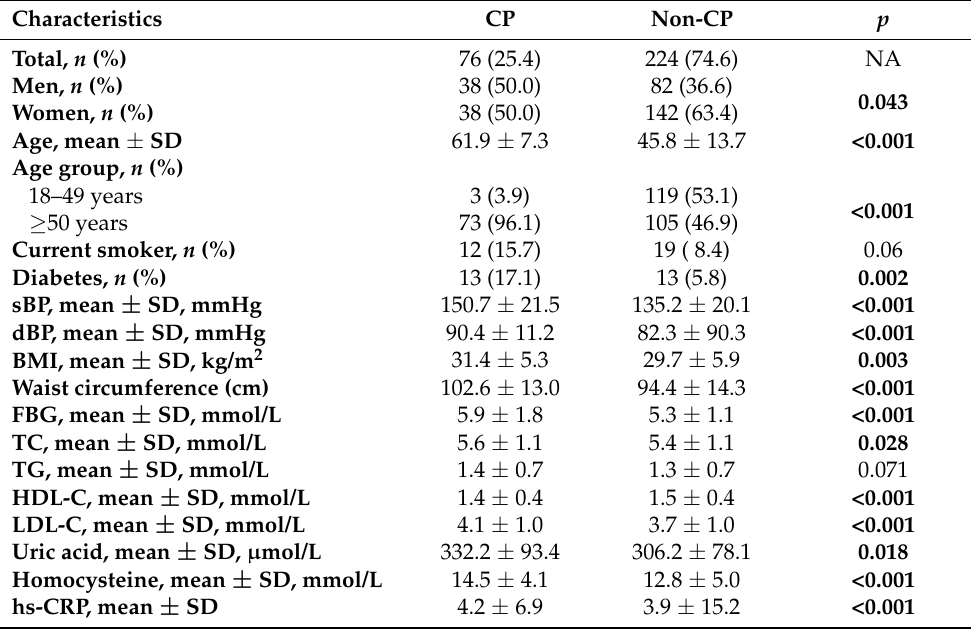
Table 3. Subjects’ characteristics depend on the presence of carotid plaques